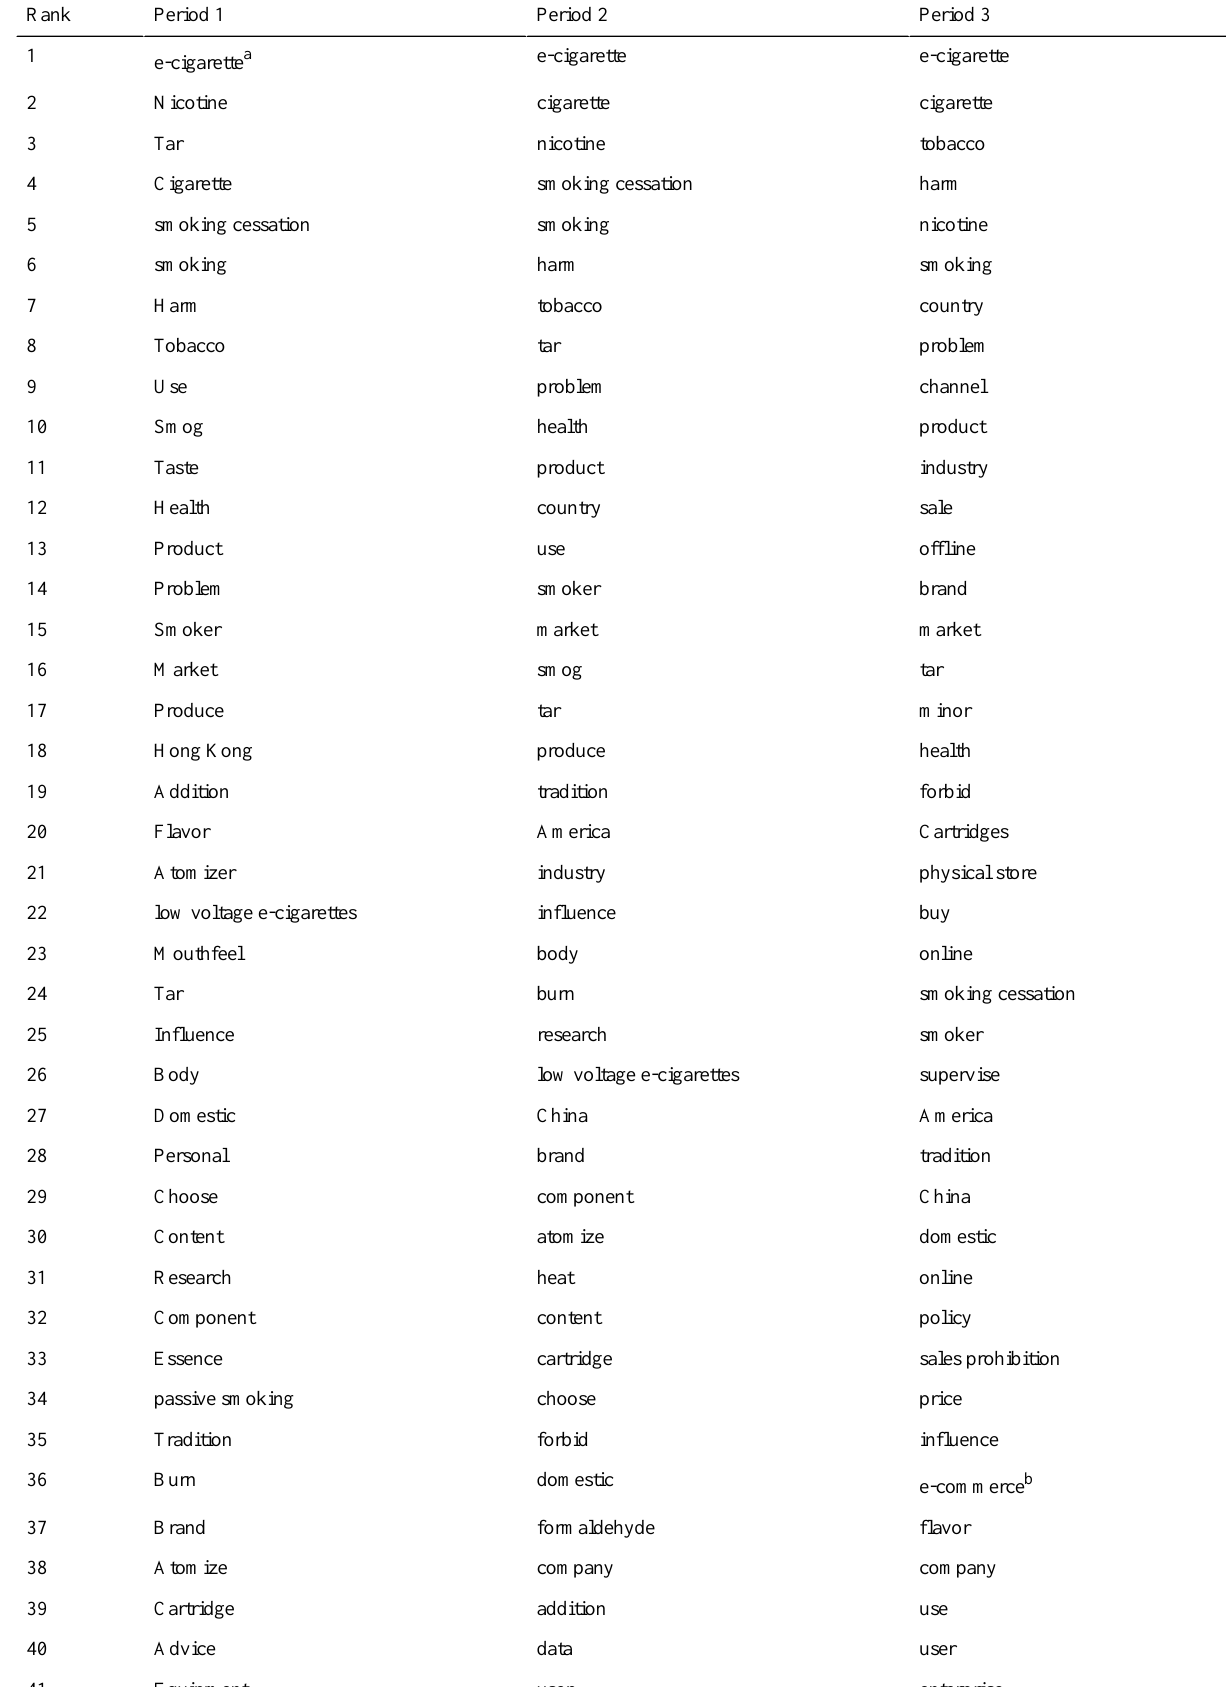
Table 1. Top 50 high-frequency words and phrases in different